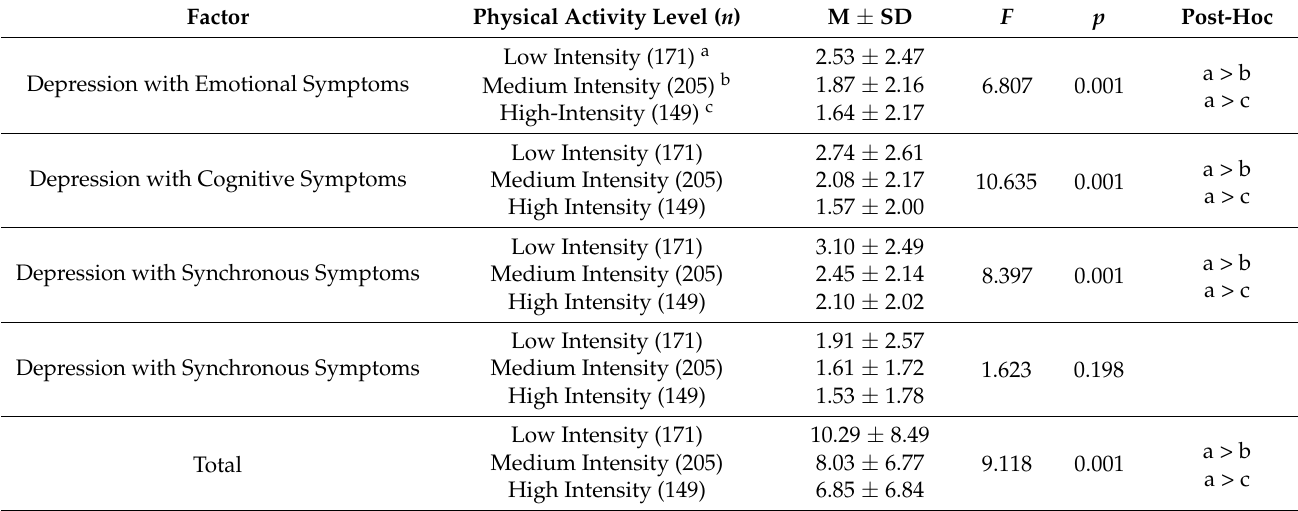
Table 6. Differences in depression according to the amount of physical activity ( n =